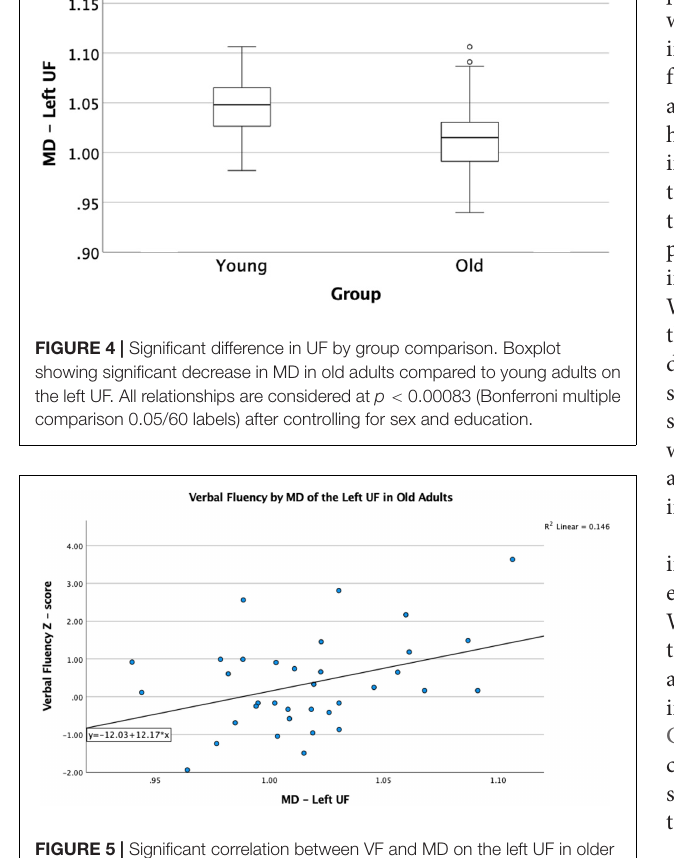
FIGURE 5 | Significant correlation between VF and MD on the left UF in older adults, after controlling for sex, p <